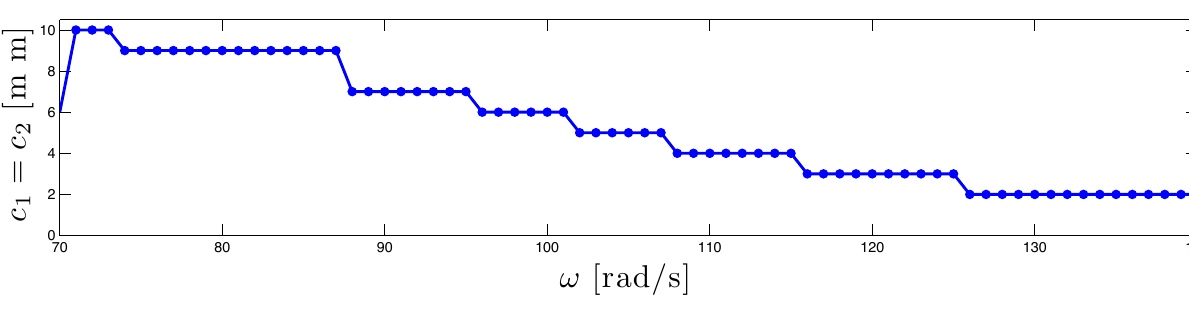
Fig. 11 Optimal choice of the clearance c 1 = c 2 for the maximal attenuation of vibrations of the rotor body corresponding to the red curve in Fig. 9, for parameters m t = 25 kg and b t = 0 N s m − 1